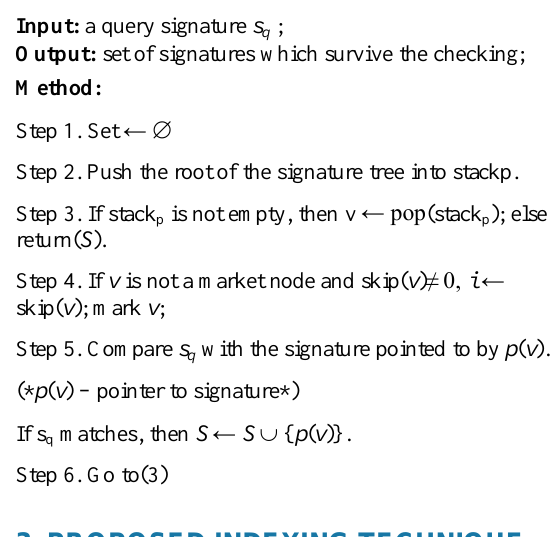
 Algorithm 2 [4] signature-graphs-search